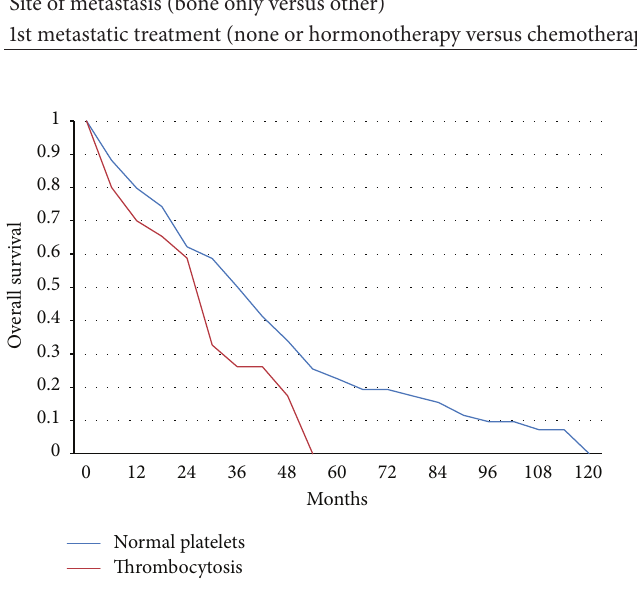
Figure 1: Kaplan-Meier overall survival curves in months from the diagnosis of metastatic disease of patients with normal platelet counts (150–350 × 10 9 /L) versus patients with thrombocytosis. LogRank test 𝑃 = 0.038 .